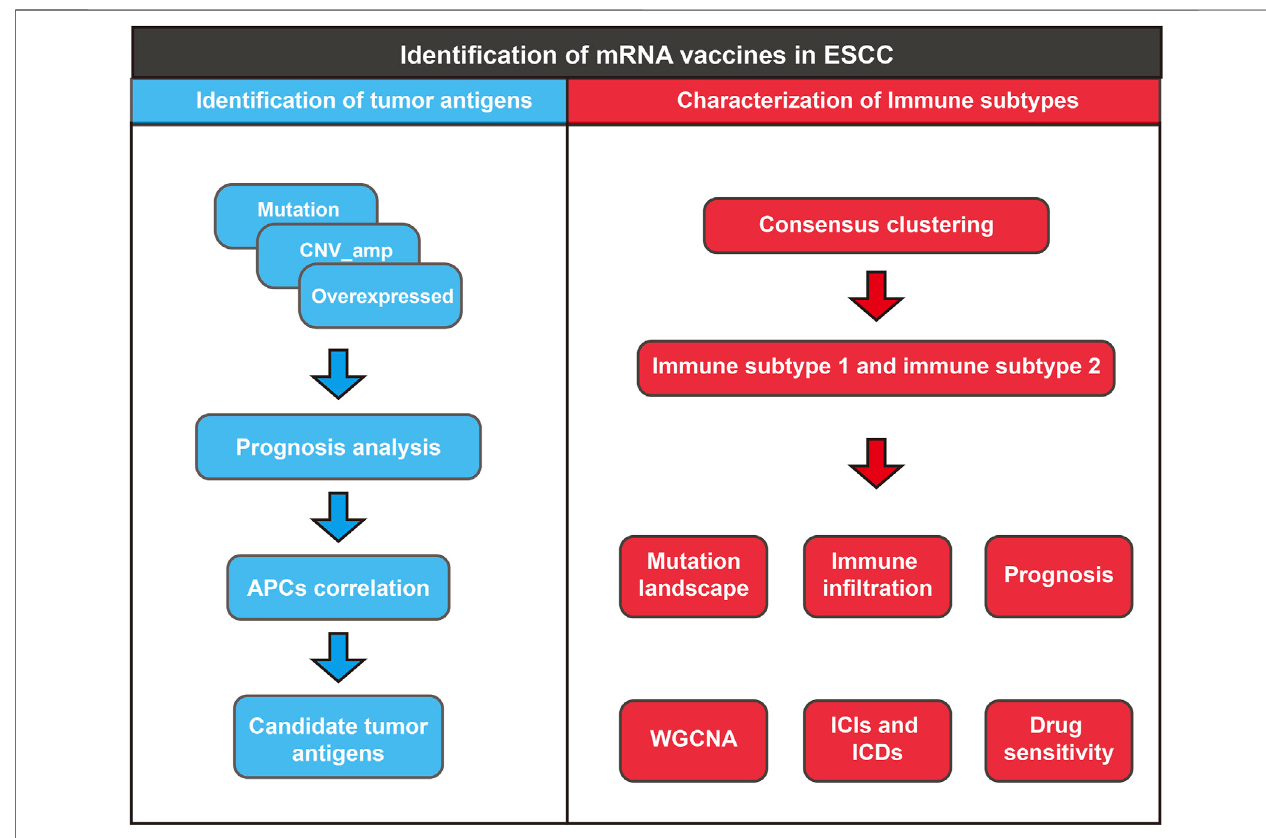
FIGURE 1 | The work fl ow of this